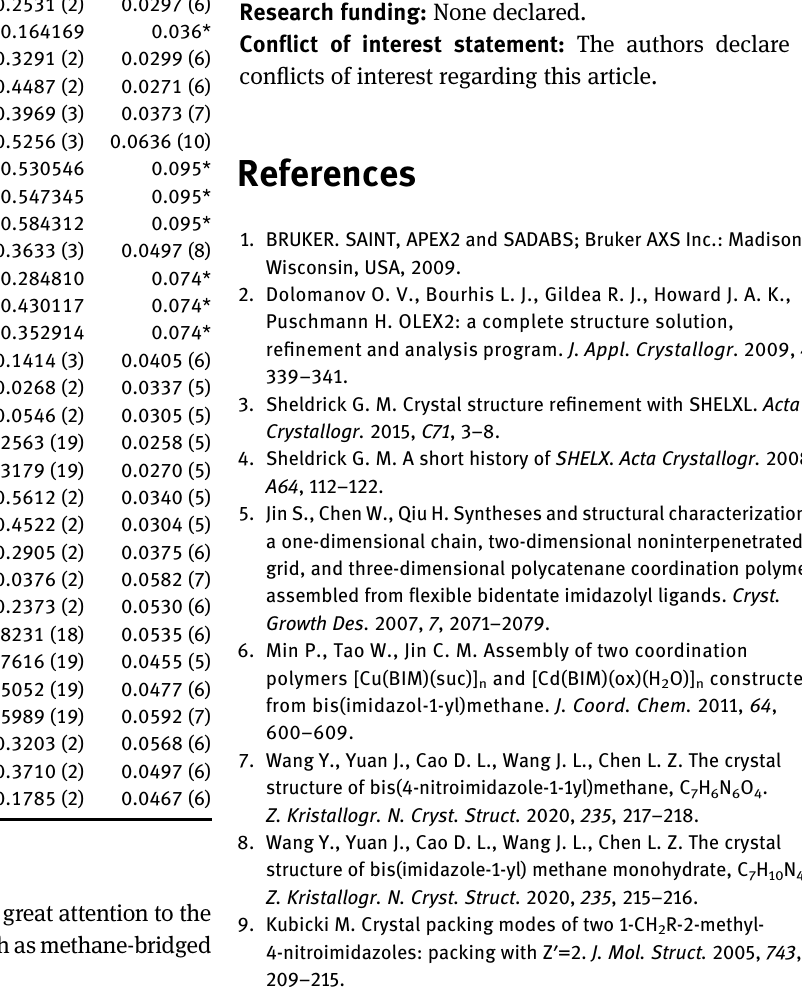
The asymmetric unit of the title structure contains one target molecule and one acetone molecule (see the Figure). The nitroimidazole rings are almost flat, and the dihedral angle of the two nitroimidazole rings is 46.18 ° . In general, all bond lengths and angles are in the expected ranges in both molecules [9].